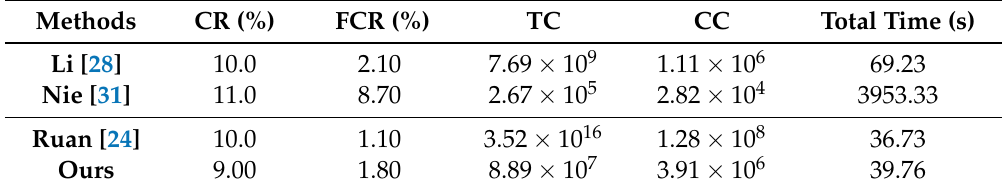
Table 3. Comparison of the averaged results with those of state-of-the-art methods on the whole